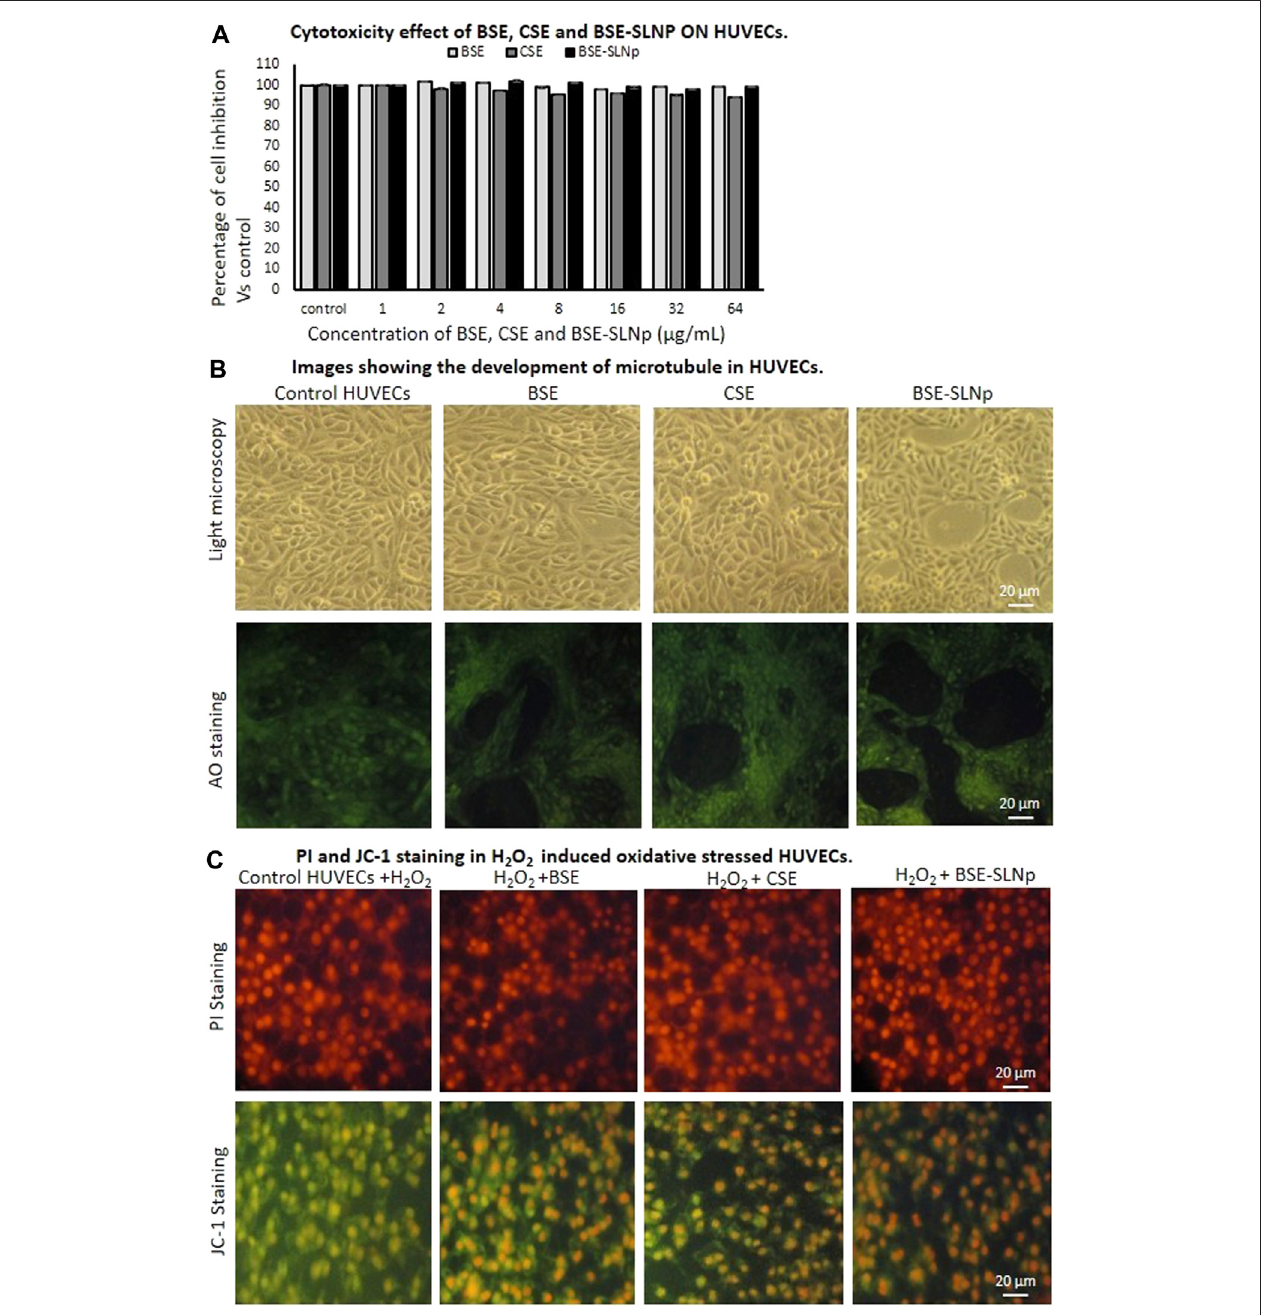
FIGURE 6 | In vitro cytotoxicity (6A) , microtubule development (6B) , PI and JC-1 (6C) stained microscopic image analysis of vehiclecontrol, BSE, CSE, and BSE- SLNp treated H 2 O 2 induced oxidativestressed HUVECs after 48 h. Each value is means ± SD ( n (cid:2) 6). In PI staining, the nucleus appeared tobe normal and there are no signsofshrunken,pyknosis, orapoptotic nucleus. BSE-SLNptreatedadipocyteshowinghighJ-aggregatesdirectlyrepresentingactivemitochondria(highMMP, Δψ m